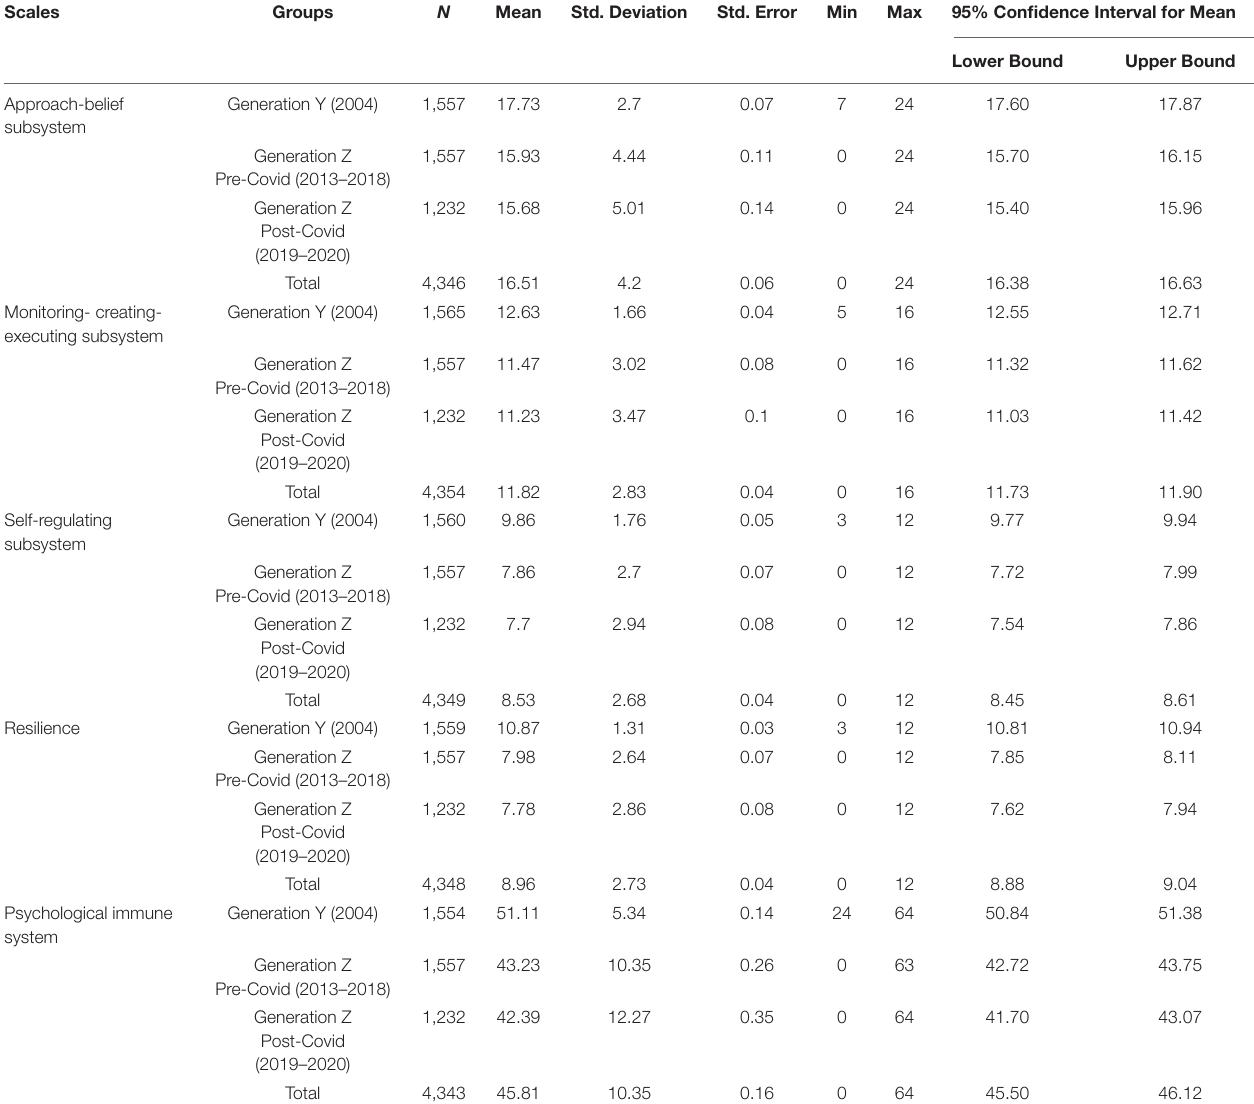
TABLE 2 | Descriptive statistics of the scales. Scales Groups N Mean Std. Deviation Std. Error Min Max 95% Confidence Interval for Mean